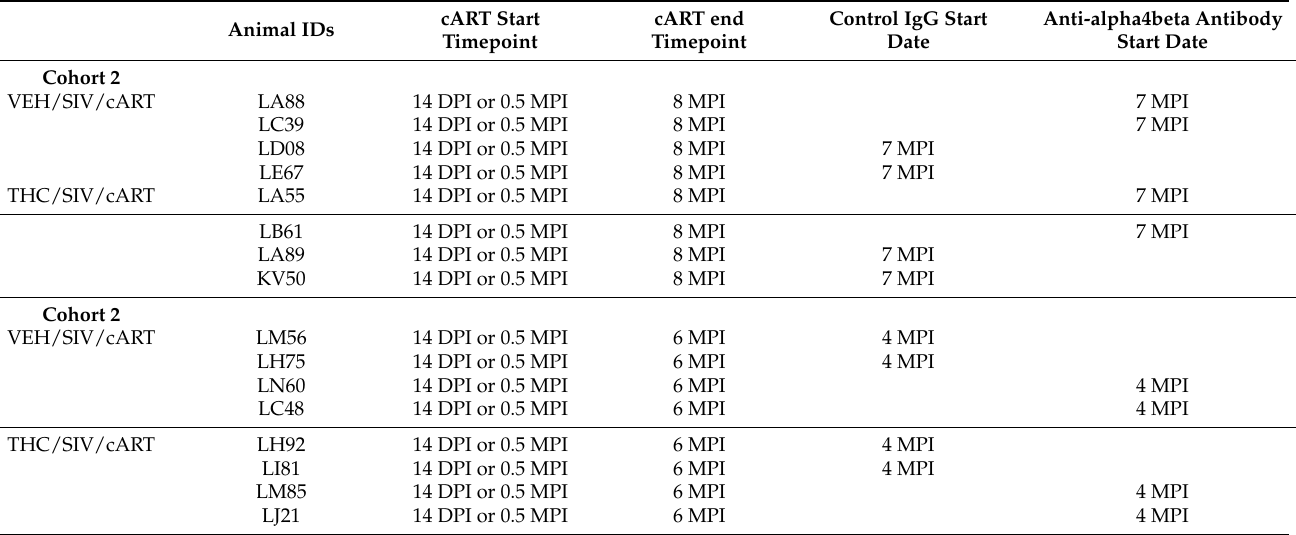
Table 2. Animal IDs and additional treatments during the study